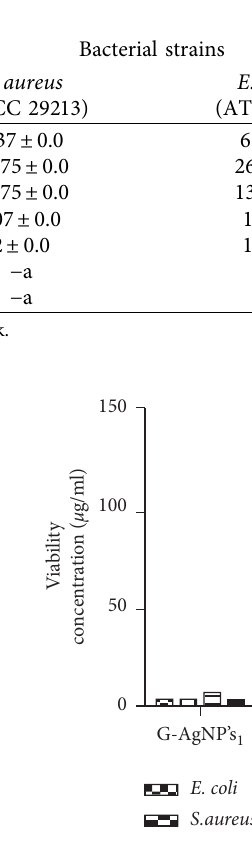
Table 4: Minimum inhibitory concentrations of Ag nanomaterials.